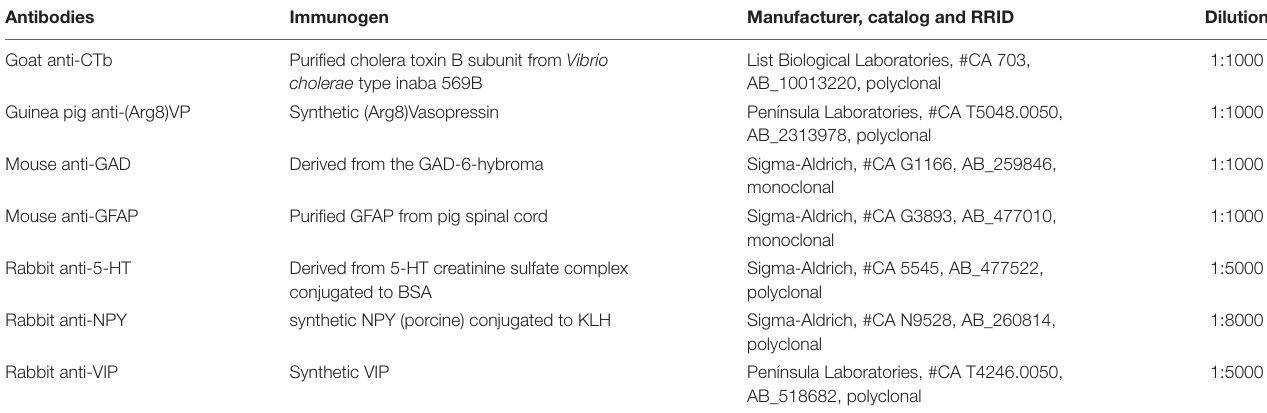
TABLE 1 | Characteristics of antibodies used.